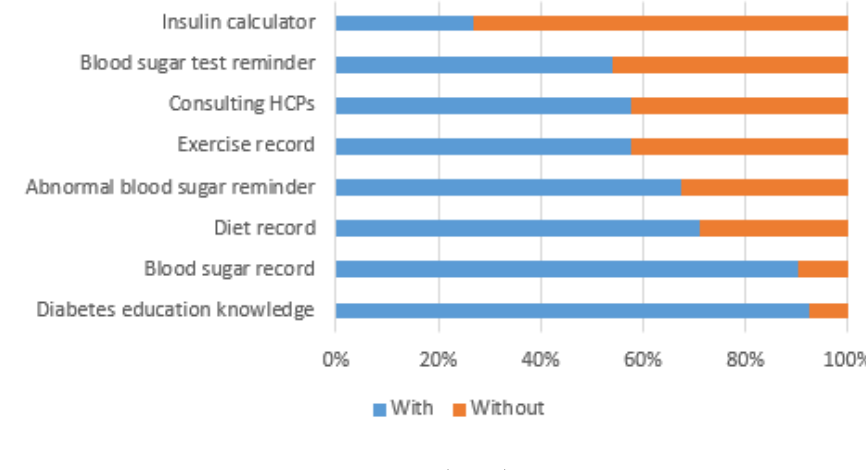
Figure 4. Usefulness of app functions reported as important by patients